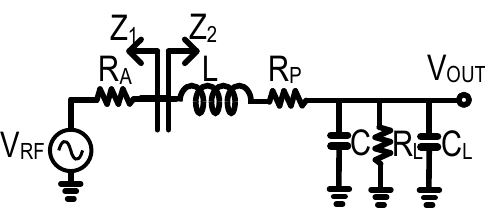
Figure 10. Model of the matching condition for the RFEH front-end.